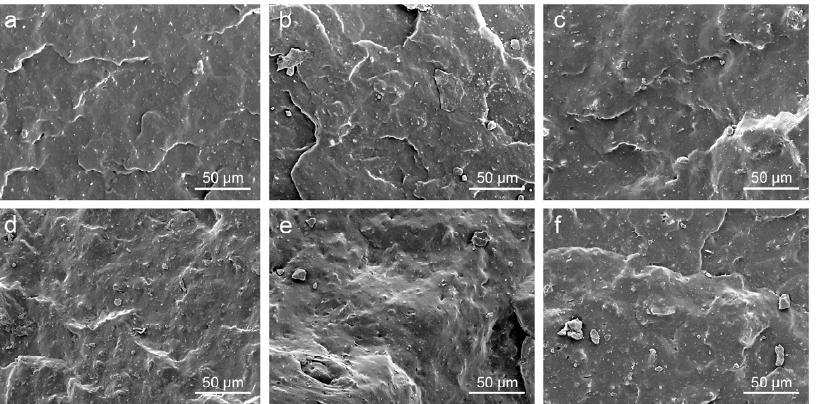
Figure 7. SEM images of the NR composites filled with various Si69-RHS loadings: ( a ) 0 phr, ( b ) 10